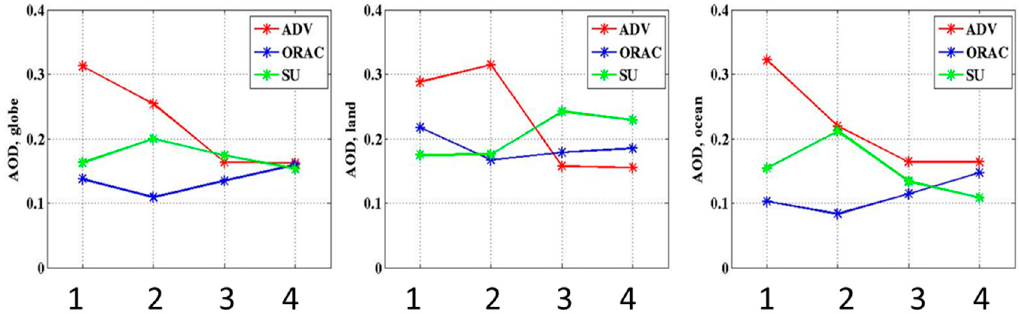
Figure 4. Evolution of the monthly mean AOD for September 2008 from three algorithms during the four stages (here denoted as 1–4, as in Figure 3) of the development cycle; ( left ) global average; ( center ) global land average; ( right ) global ocean average.